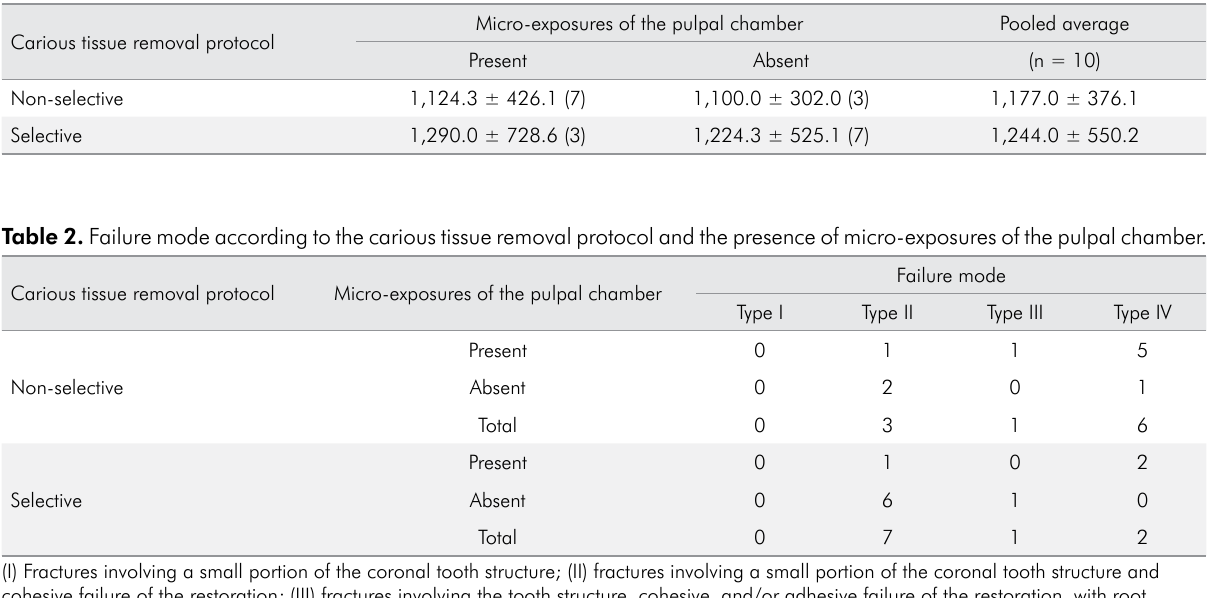
Table 1. Means ± standard deviation (n) of fracture strength according to the carious tissue removal protocol and the presence of micro-exposures of the pulpal chamber.